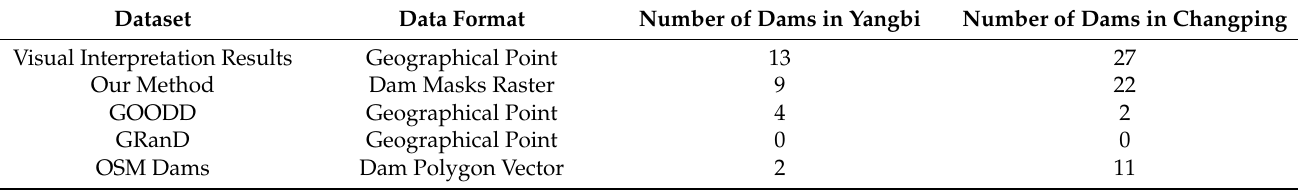
Table 7. Comparison of the number of dams in Yangbi and Changping from different datasets with visual interpretation